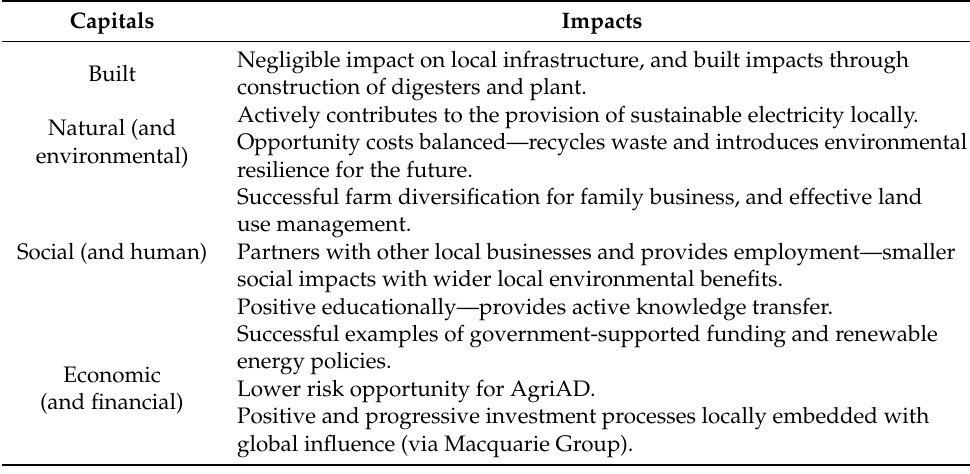
Table 4. Capitals, change variables, and their interpretation: AgriAD.